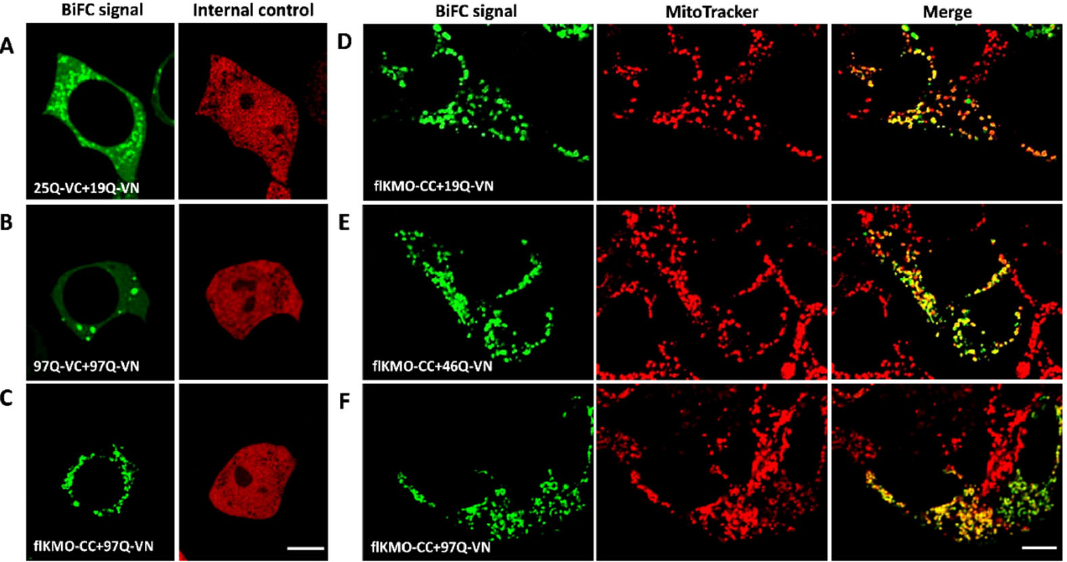
Figure 4. Cellular localisation of BiFC complexes in live HEK293T cells, using confocal microscopy. Cells were seeded on ibiTreat dishes and co-transfected with BiFC constructs for 48 h. ( A – C ) illustrate the HTT signal using the BiFC system (BiFC signal = left image, and internal control RFP signal = right image) in each panel. ( A ) Cells were transfected with 19Q-VN, 25Q-VC and RFP, the BiFC signal is cytosolic and slightly punctate. ( B ) Cells were transfected with 97Q pair and RFP; the BiFC signal is generally cytosolic, with HTT inclusions present. ( C ) Cells were transfected with flKMO-CC, 97Q-VN and RFP; the BiFC signal is mainly mitochondrial as suggested by the dotted appearance of the signal. Scale bar = 8 µ m. ( D – F ) Localisation of KMO-BiFC complexes. Left panels show BiFC signal of the following pairs: ( D ) flKMO-CC and HTT19Q-VN, ( E ) flKMO-CC and HTT46Q-VN, and ( F ) flKMO-CC and HTT97Q-VN. Second column of panels ( D – F ): mitochondria stained with MitoTracker Red CMXRox (M-7512). Third column of panels ( D – F ): merge of the BiFC signal and the MitoTracker signal. Scale bar = 8 µ m. The BiFC signal in panels ( D – F ) exhibits dotted structures that co-localise with the MitoTracker signal, as seen in the merge images in the right panels of ( D – F ). This confirms the mitochondrial localisation of all the BiFC complexes of flKMO-CC with different polyQ lengths of